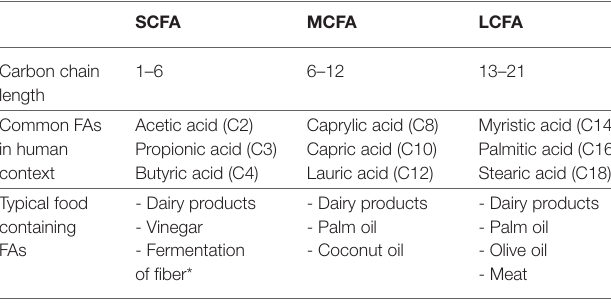
TABLE 1 | Overview of characteristics of different fatty acids according to chain length. SCFA